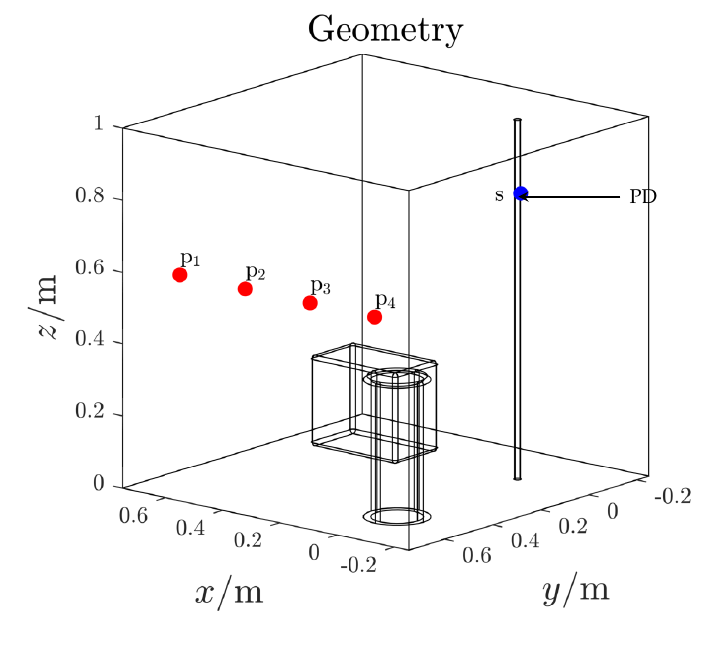
Figure 16. Test case 2. 3D domain including also the dielectric and ferromagnetic